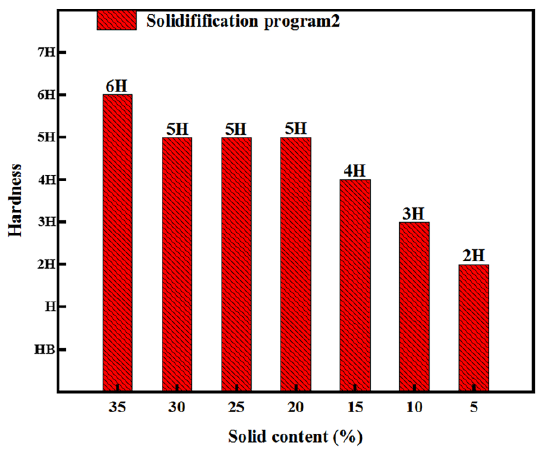
Figure 6. Hardness diagram of coating with different solid content.